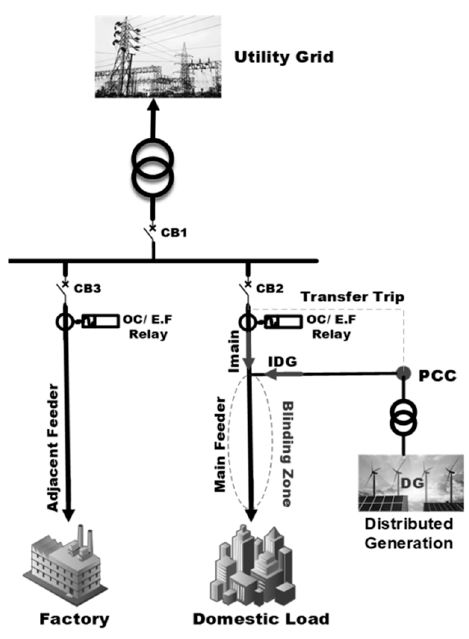
Figure 4. Possible blinding zones in a typical distribution network.